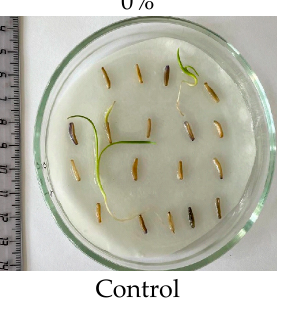
Figure 3. Seed germination of S. tau-saghyz seeds following a 4 h pre-treatment with various VCT concentrations (12th day): ( Control ) without VCT priming; ( A ) 1% VCT; ( B ) 5% VCT; ( C ) 10% VCT;.